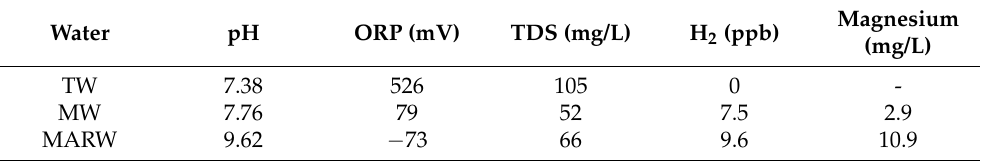
Table 1. Properties and magnesium content of TW, MW and